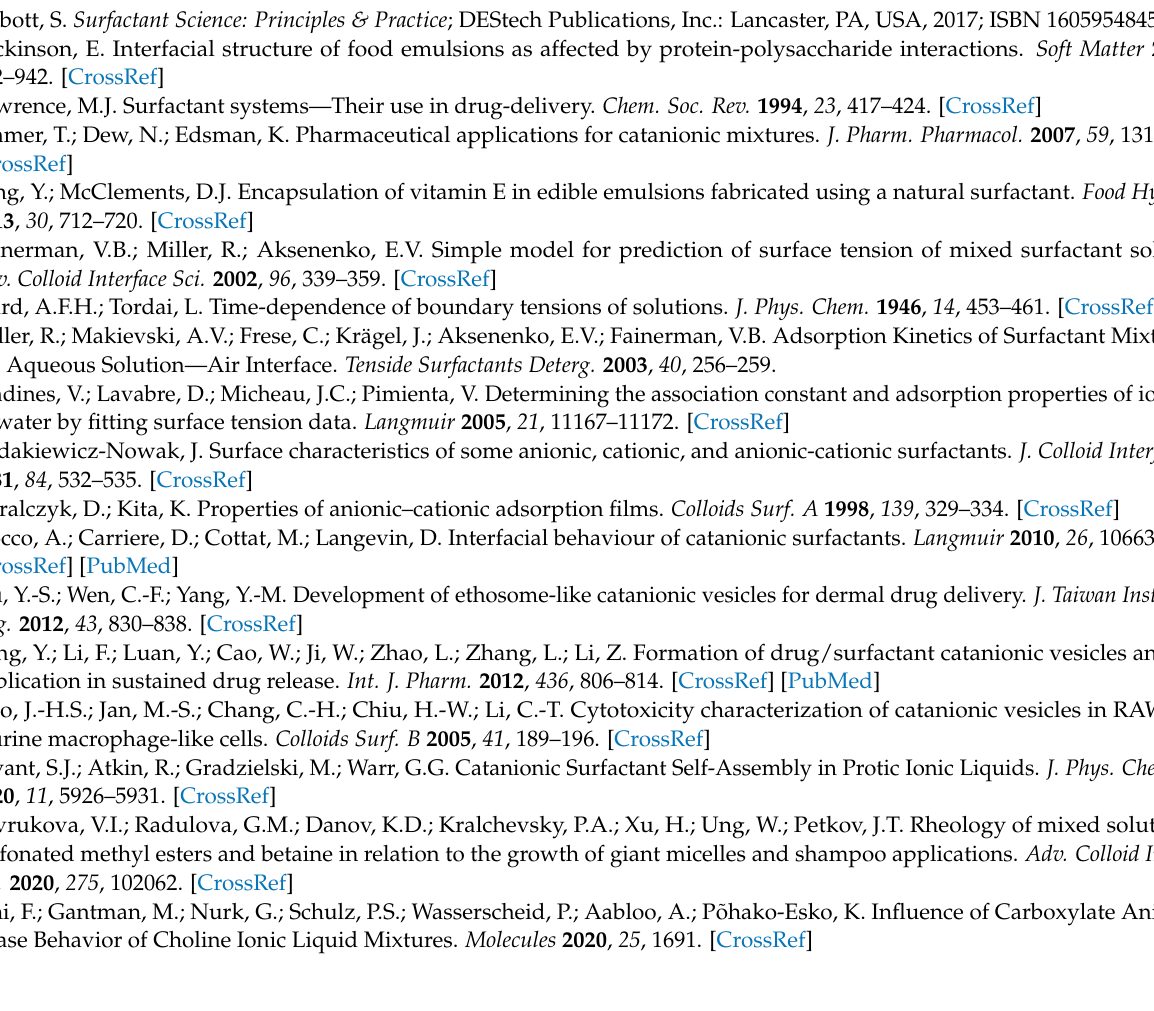
C 12 TAB mixtures at the water/hexane interface measured by PAT-1, Table S1: Parameter values obtained by fitting the reorientation adsorption model Equations (4) and (5) and the diffusion equation Equation (6) to the experimental data of Figure S1 as measured for solutions of NaC 16 SO 4 + C 12 TAB, Figure S2: Dynamic interfacial tension of mixed aqueous solutions of NaC 12 SO4 + C 16 TAB at the water/hexane interface measured by PAT-1, Table S2: Parameter values obtained by fitting the reorientation adsorption model Equations (4) and (5) and the diffusion equation Equation (6) to the experimental data of Figure S2 as measured for solutions of NaC 12 SO 4 + C 16 TAB, Figure S3: Dynamic interfacial tension of mixed aqueous solutions of NaC 12 SO 4 + C 6 TAB mixtures at the water/hexane interface measured by PAT-1, Table S3: Parameter values obtained by fitting the reorientation adsorption model Equations (4) and (5) and the diffusion Equation (6) to the experimental data of Figure S3 as measured for solutions of NaC 12 SO 4 + C 6